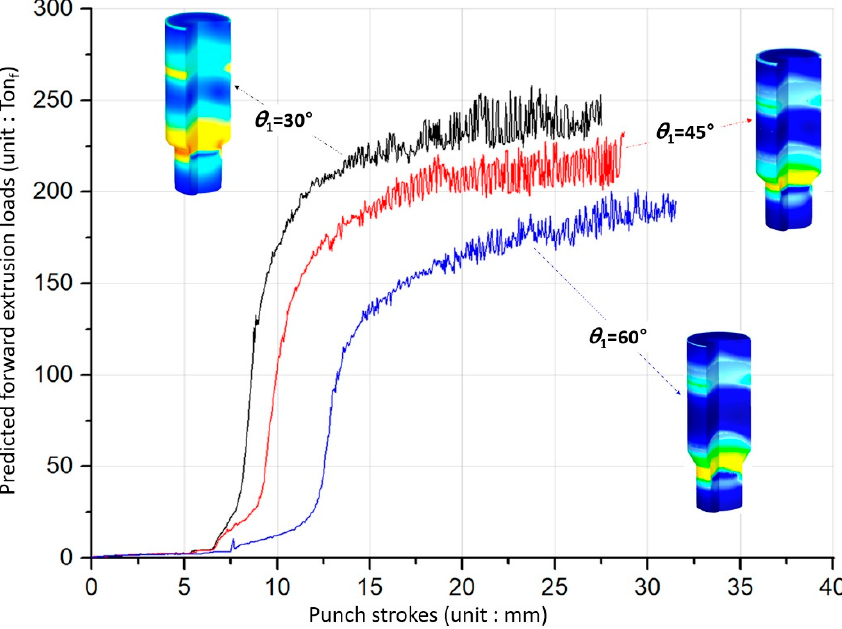
Figure 8. Cold forging load histories for the forward extrusion of the preform.